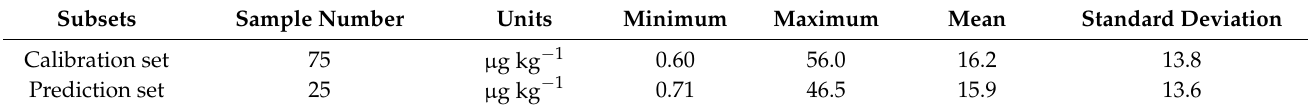
Table 1. The AFB 1 values measurement result in the calibration and prediction